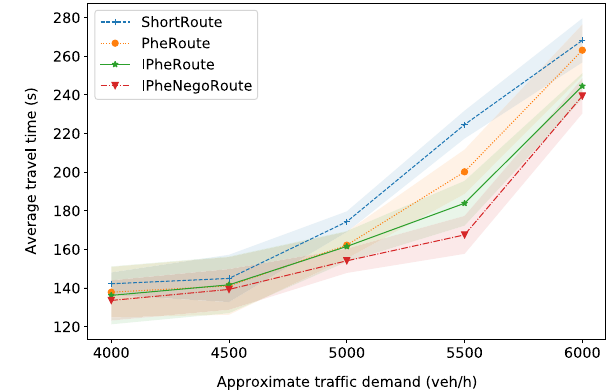
Fig. 6 Average fuel consumption results of traffic routing methods in the Yeouido island traffic network scenario